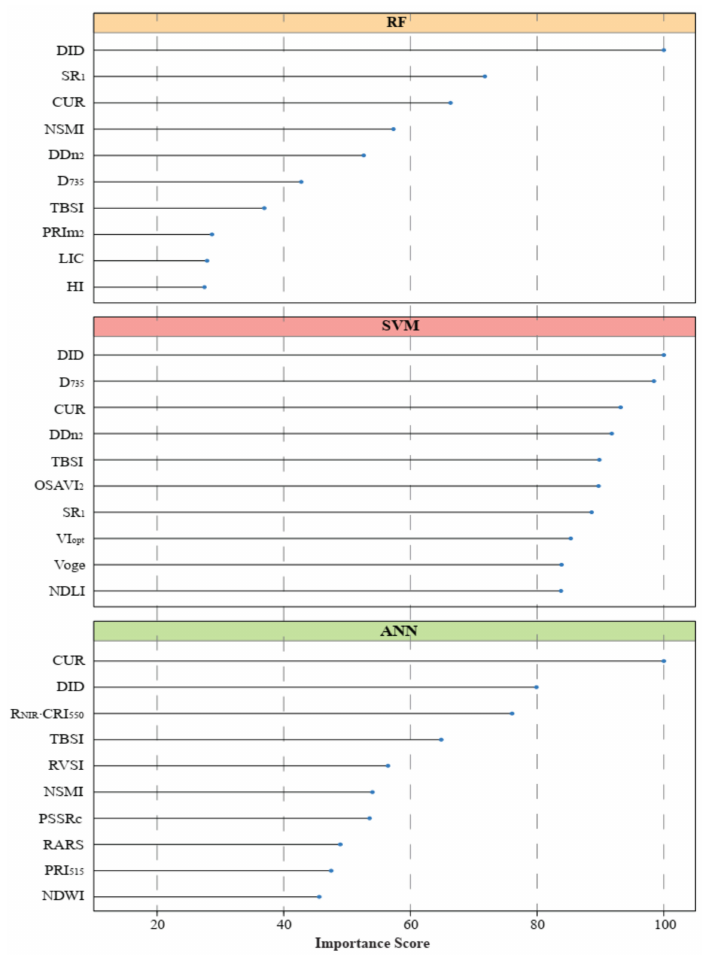
Figure 8. Importance of spectral variables in three classification